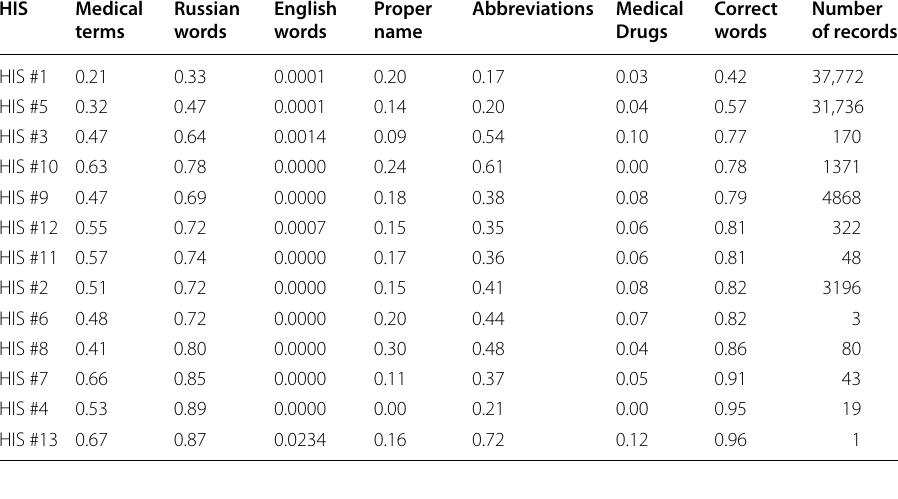
Table 2 Metacharacteristics: misprints, terms, abbreviations according to dictionaries HIS